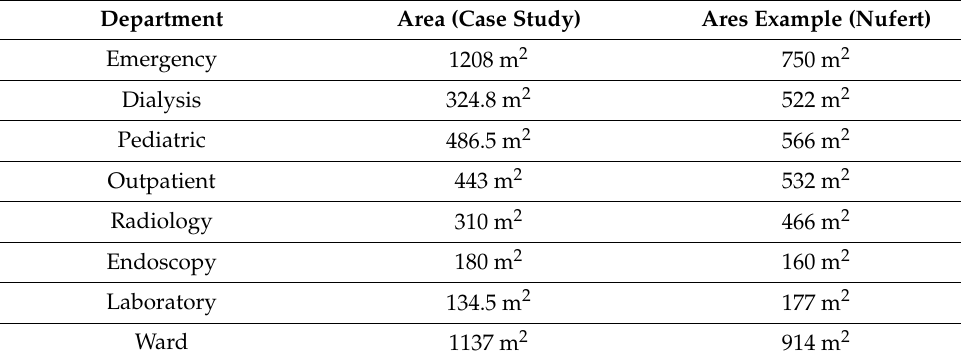
Table 11. Examples used in the space syntax analysis.